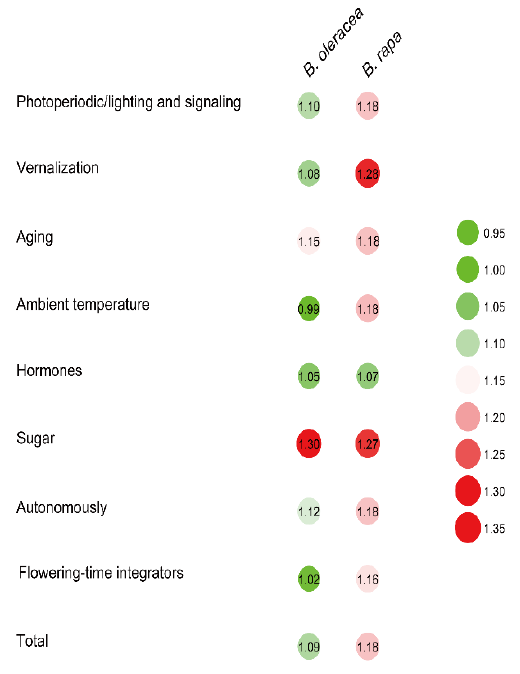
Figure 1. Gene expansion comparison among B. napus , B. rapa , and B. oleracea . The method is explained in Material and Methods and the colors represent the various degrees of gene expansion. If Γ is less than one in pathway A , the flowering-time pathway A in B. napus experienced an expansion event, while if greater than one, a contraction event occurred in this pathway. The Γ is greater, the contraction is more serious.